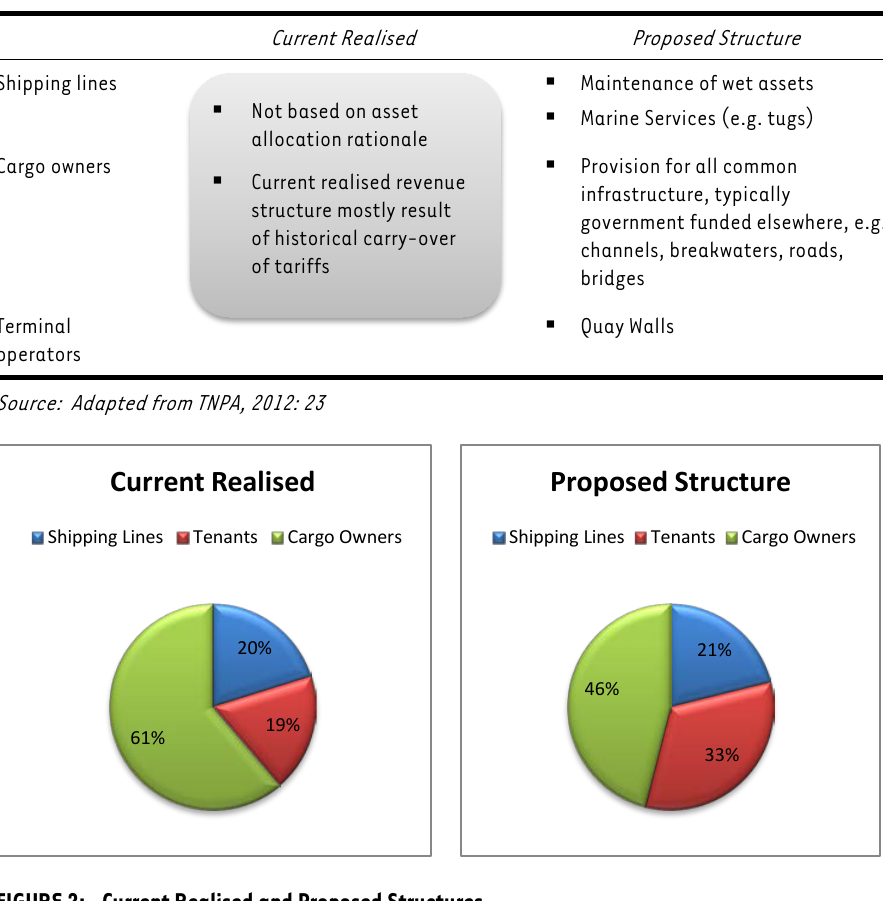
FIGURE 2: Current Realised and Proposed Structures Source: Adapted from TNPA, 2012: